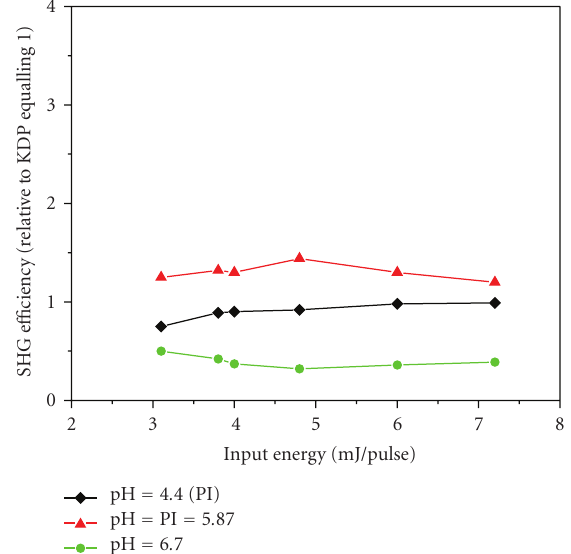
Figure 26: UV-Vis-NIR spectrum of L-threonine at di ff erent pH values.